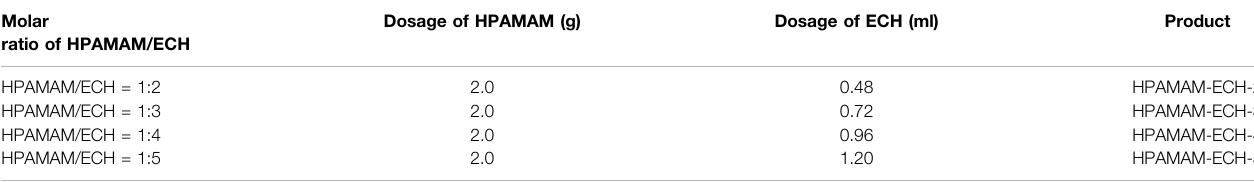
TABLE 1A | Formulation of HPAMAM-ECH samples. Molar ratio of HPAMAM/ECH